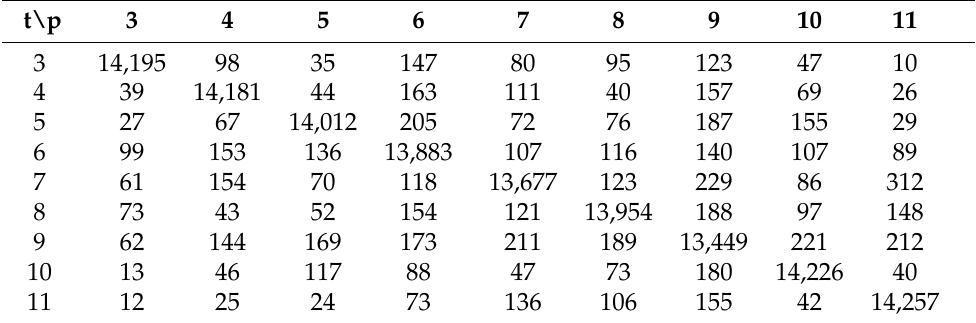
Table 10. The confusion matrix of the SPPB model. The class with the least false classifications is 3 and the class with the most false classifications is 9. t = true label, p = predicted label.